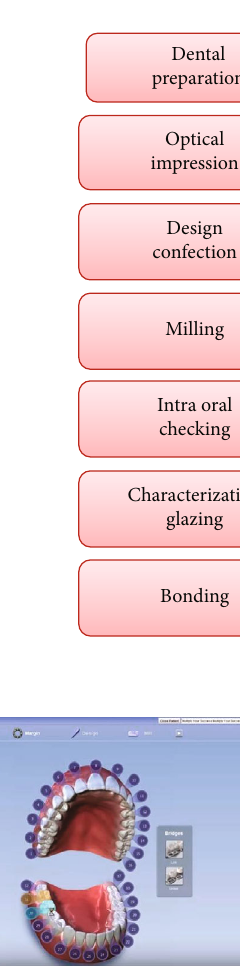
Figure 4: The administrative fi